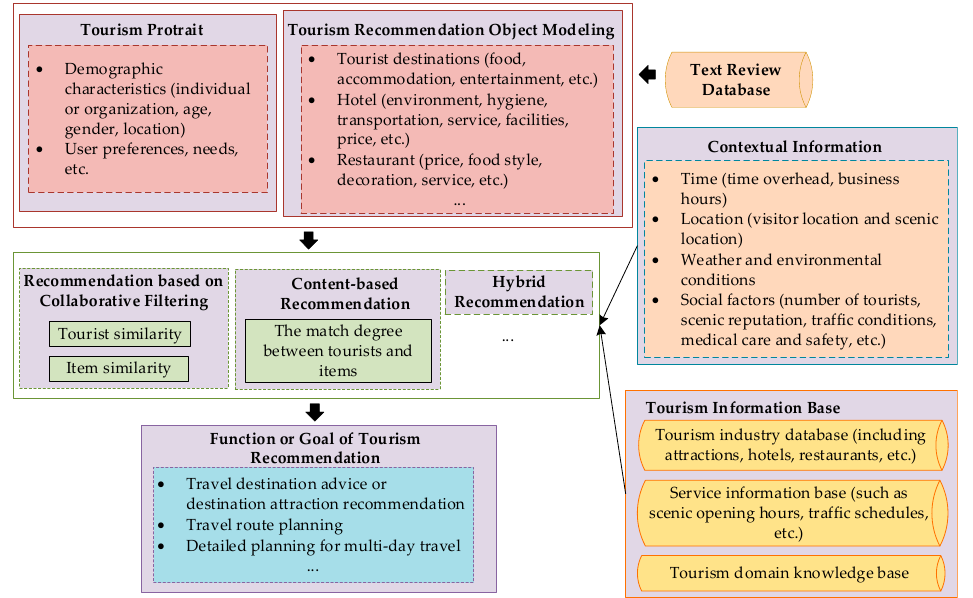
Figure 2. Tourist recommendation system framework based on text mining.